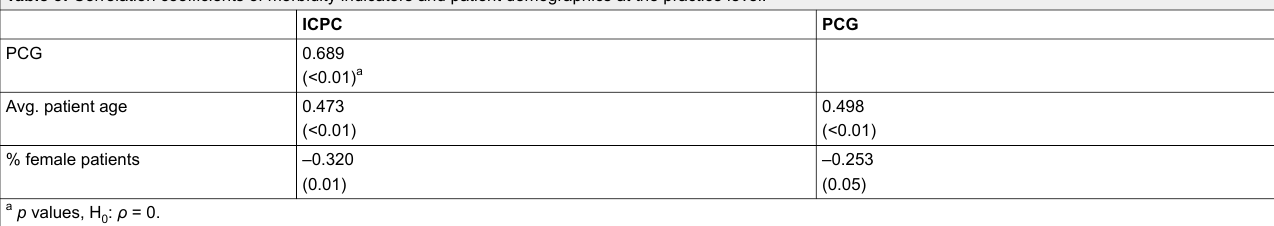
Table 3: Correlation coefficients of morbidity indicators and patient demographics at the practice level.